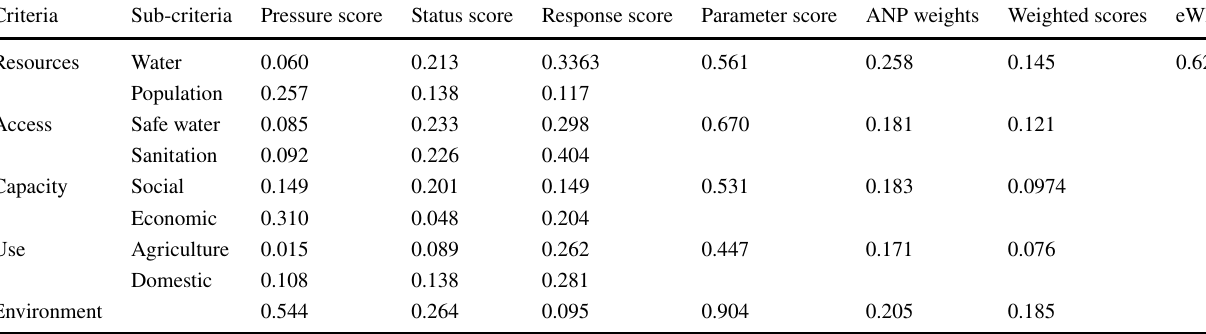
Table 7 eWPI components weighted by ANP (Watershed Scale)